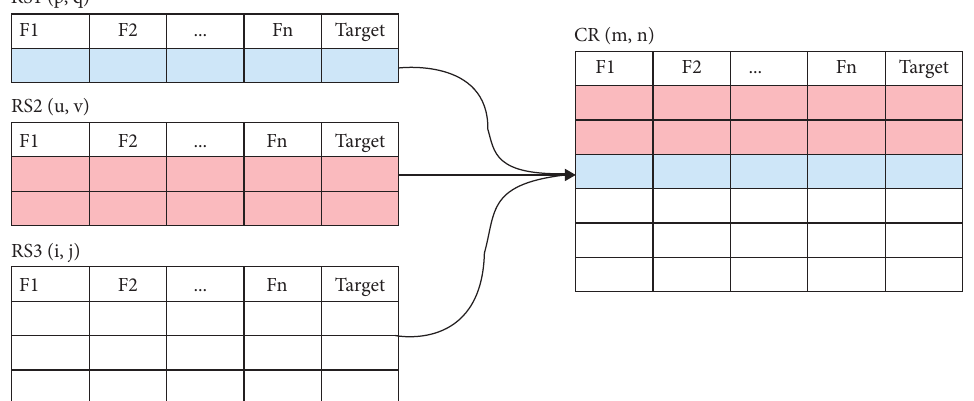
Figure 1: Proposed resampling approach diagram.